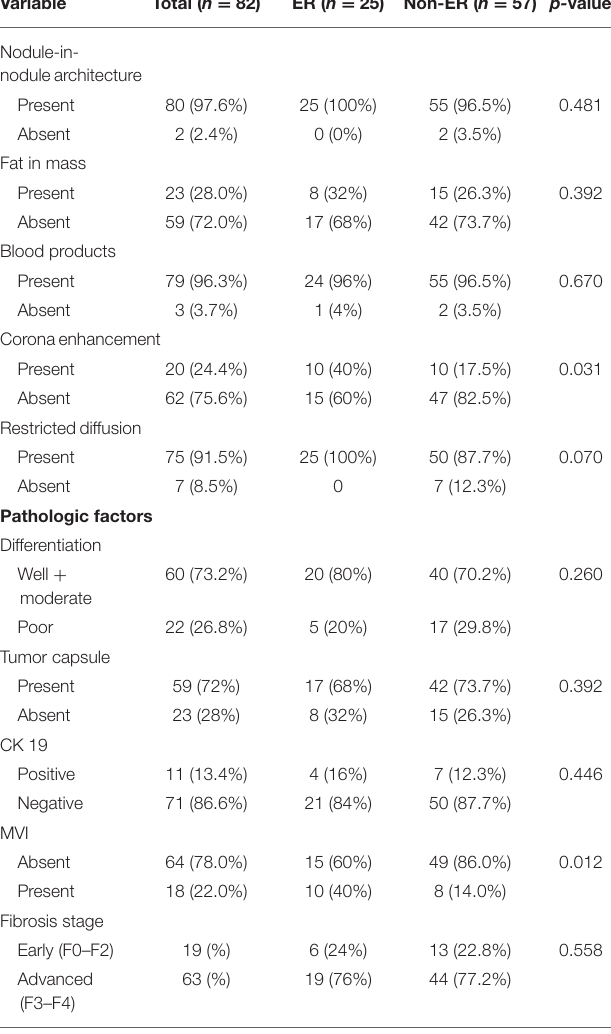
TABLE 2 | Univariate analysis of preoperative and pathologic predictors for early recurrence of eHCC patients ( n =